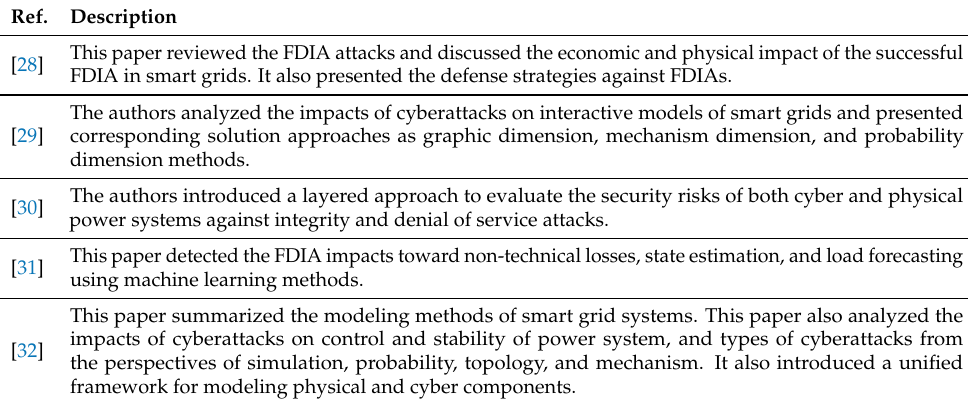
Table 1. Review papers on cyberattacks in smart grid